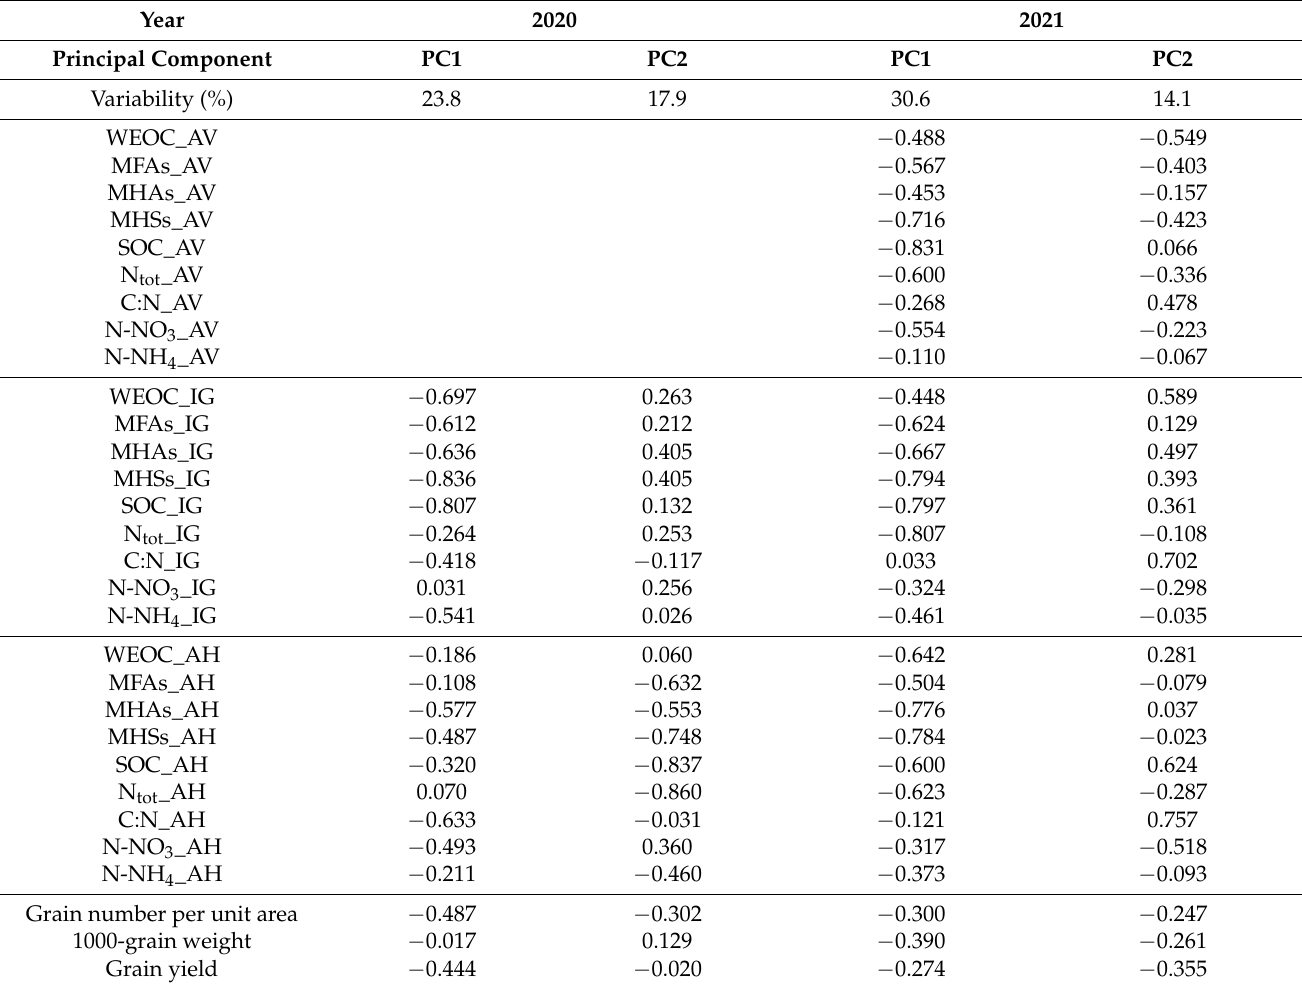
Table 7. Effect of different soil collection times on PCA-based correlations between soil quality and waxy winter wheat grain yield indicators during 2020 and 2021 seasons. For calculation, datasets with three fertilizers (ammonium nitrate, pig slurry, and anaerobic liquid digestate) and four nitrogen rates (0, 60, 120, and 120 + 50 kg N · ha − 1 ) were